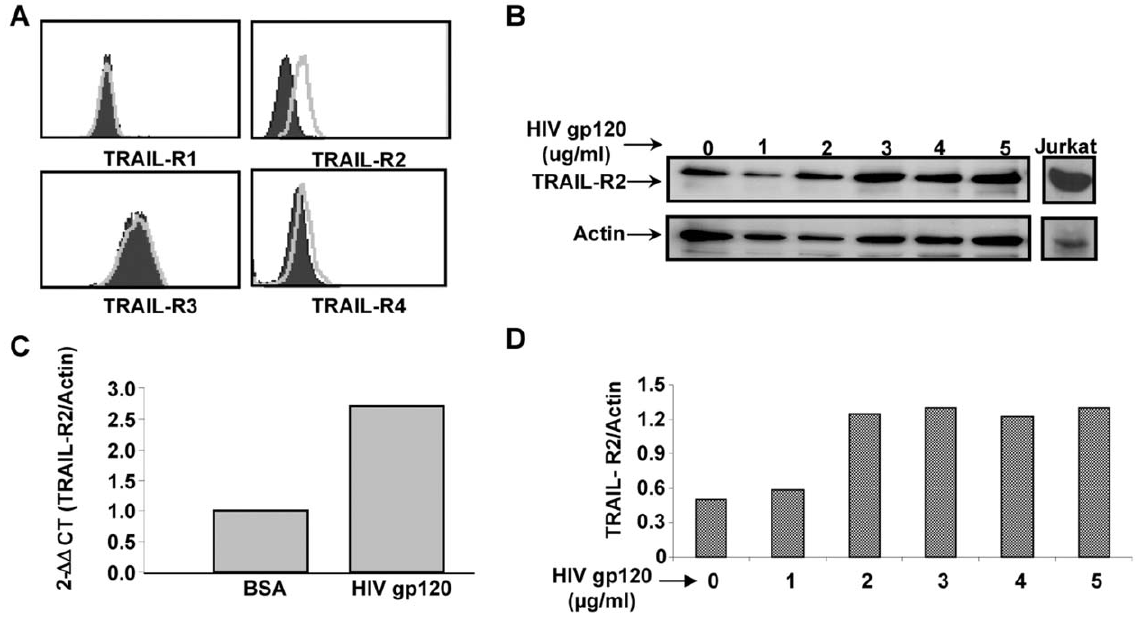
Figure 1. HIV gp120 Increases TRAIL-R2. (A) Huh7 cells were incubated with increasing concentrations of HIV gp120 and analyzed for TRAIL- Receptor expression by Flow cytometry for TRAIL-R1, -R2, -R3, -R4 (BSA = black, HIV gp120= Grey), (B and D) Western blot (C) or real time PCR.